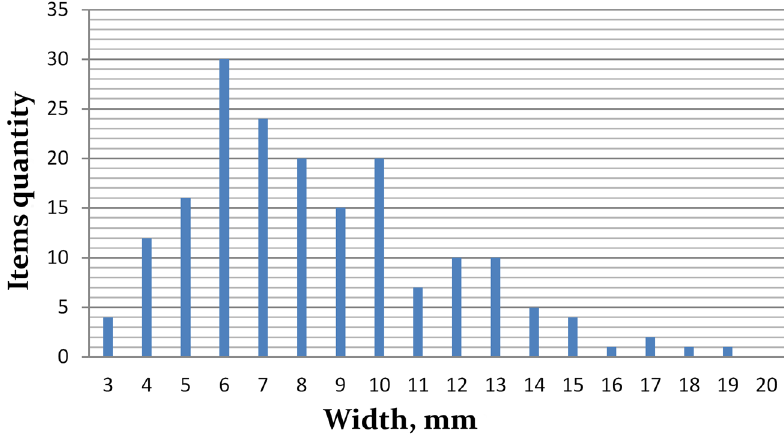
Figure 11: Kamyana Mohyla 1 site. Width of blades and bladelets plotted at 1 mm